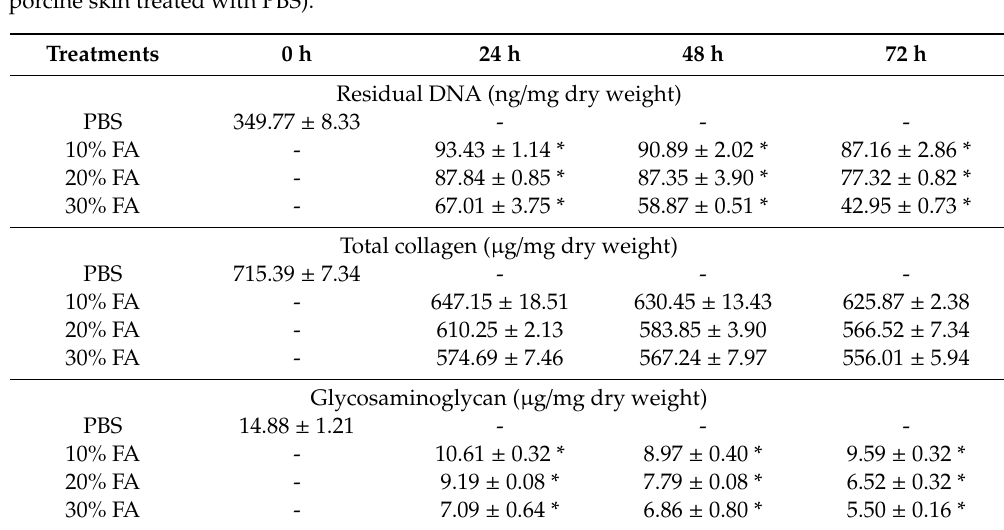
Table 3. Contents of residual DNA, total collagen and glycosaminoglycan (GAG) of porcine skin following decellularization at various concentrations of formic acid (FA) for di ff erent time points compared to fresh porcine skin treated with phosphate-bu ff ered saline (PBS) under the same processing steps. Values are presented as the mean ± standard deviation ( n = 3). (* p < 0.05 compared to fresh porcine skin treated with